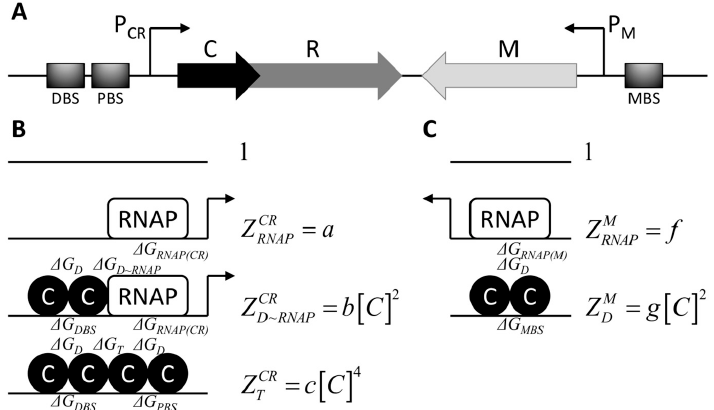
Figure 1. Modelling regulation of transcription in the R-M system Esp1396I. ( A ) Gene organization in the Esp1396I system: genes encoding control (C) protein and restriction endonuclease (R) are co-transcribed from the P CR promoter, while the gene encoding methyltransferase (M) is transcribed from the P M promoter. DBS (distal binding site), PBS (proximal binding site) and MBS (binding site in the P M ) represent three binding sites for C protein, where PBS and MBS overlap with the corresponding core promoters (RNAP binding sites); ( B ) Allowed configurations of RNA polymerase (a rectangle denoted as “RNAP”) and C protein molecules (circles) on the P CR and ( C ) the P M promoters are schematically represented. Configurations in which the promoter is transcriptionally active are labelled with an arrow. The following free energies of protein-DNA and protein-protein interactions are indicated in the figure: ∆ G RNAP(CR) and ∆ G RNAP(M) —for binding of RNAP to P CR and P M , respectively; ∆ G ∆ G ∆ G DBS , PBS and MBS —for binding of a C dimer to the distal and the proximal binding sites, and to the binding site in the P M region, respectively; ∆ G D —for C protein dimerization; ∆ G D~RNAP —for the interaction between the C dimer bound to the DBS and RNAP; ∆ G T —for interaction between two bound C dimers. For each configuration, a statistical weight is assigned (on the right of the configuration), expressed in terms of C protein concentration ([C]) and constants a, b, c, f and g that are independent of C protein